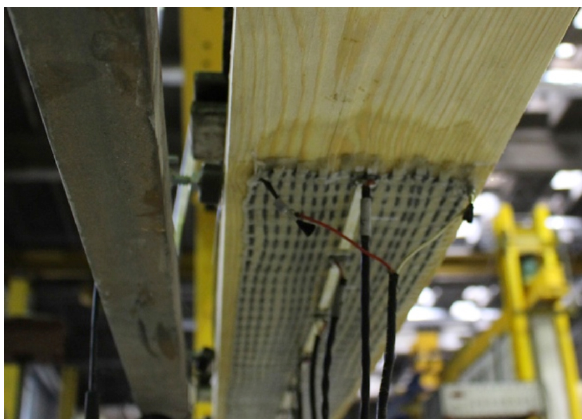
to check the mechanical performance and strengthening effectiveness. Results of the tests were compared with re- sults obtained on reference elements without strengthen- ing and with strengthening in form of regular CFRP com- mercial system.